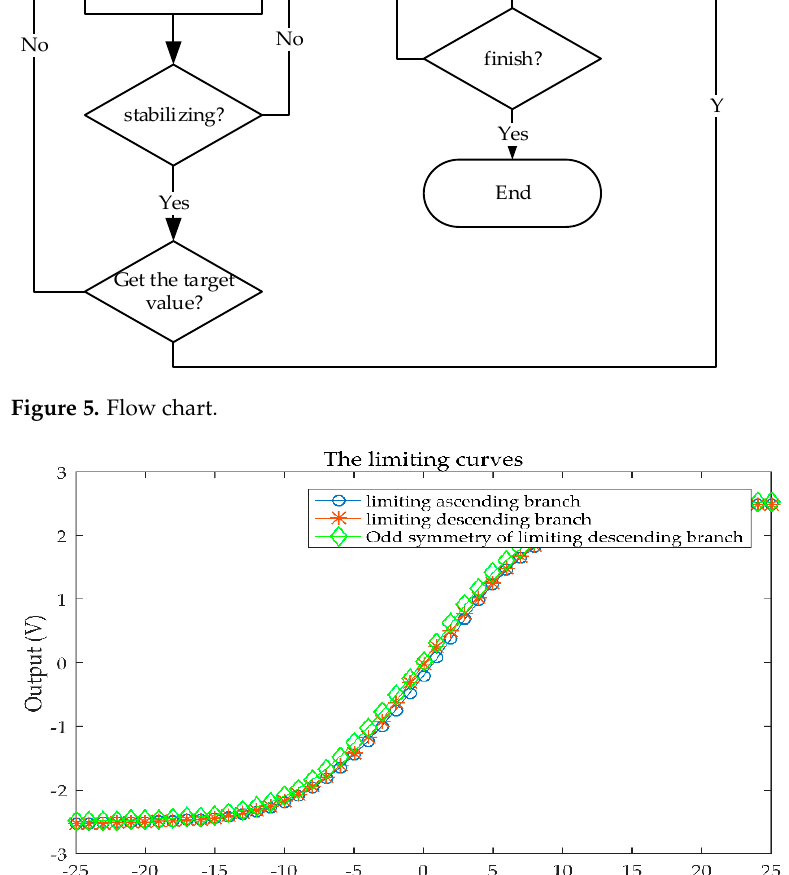
Figure 5. Flow chart.